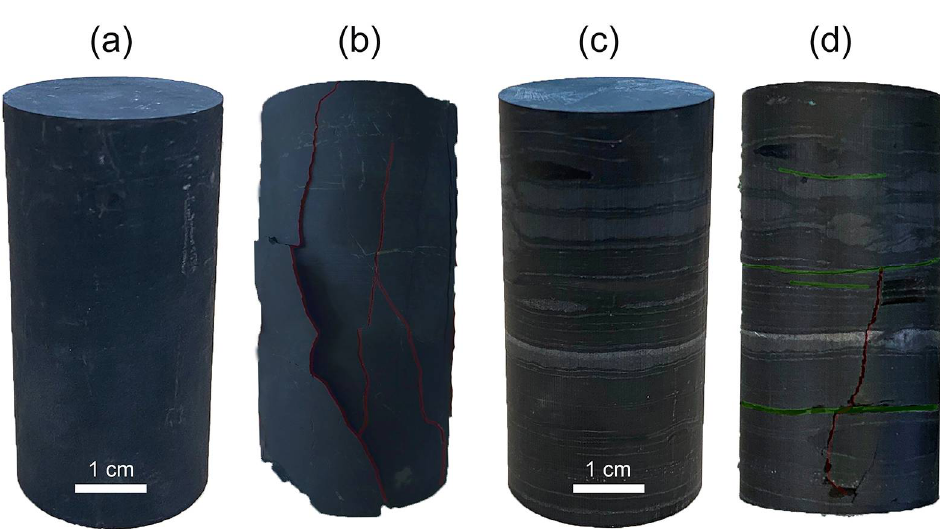
Figure 12. The cylinder marine shale, which shows homogeneity in centimeter scale ( a ); the fracture pattern of marine shale, where the crack propagates along the principal stress direction until failure ( b ); the cylinder continental shale, showing obvious lithological stratification ( c ); the fracture pattern of continental shale, where the crack propagates along the principal stress direction and activates the bedding, then shows continued growth until failure ( d ). The red line represents the principal stress cracks and the green line represents the activating bedding cracks.